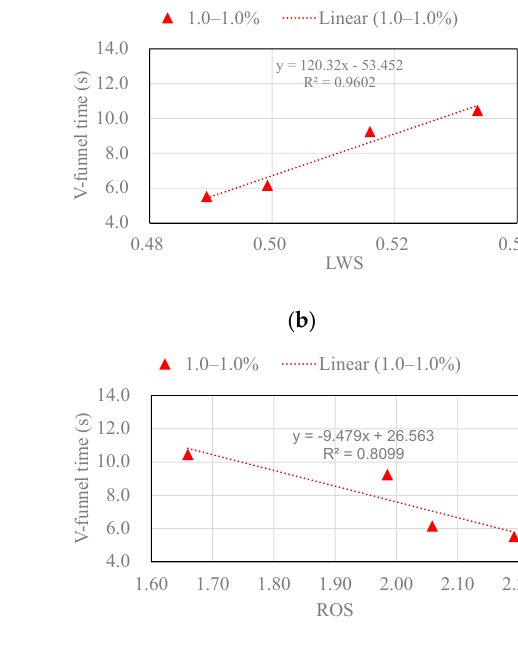
Buildings 2021 , 11 , x FOR PEER REVIEW 13 of 18